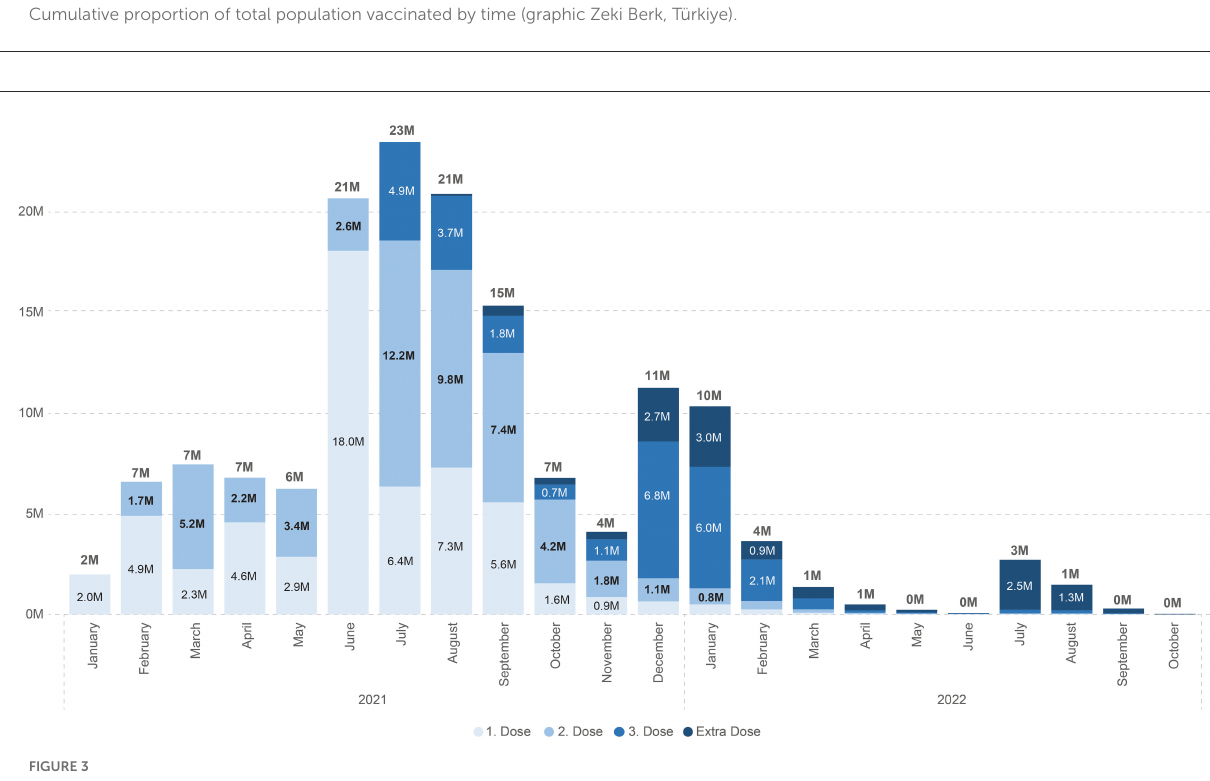
messages (Twitter especially) from the Minister. The Ministry